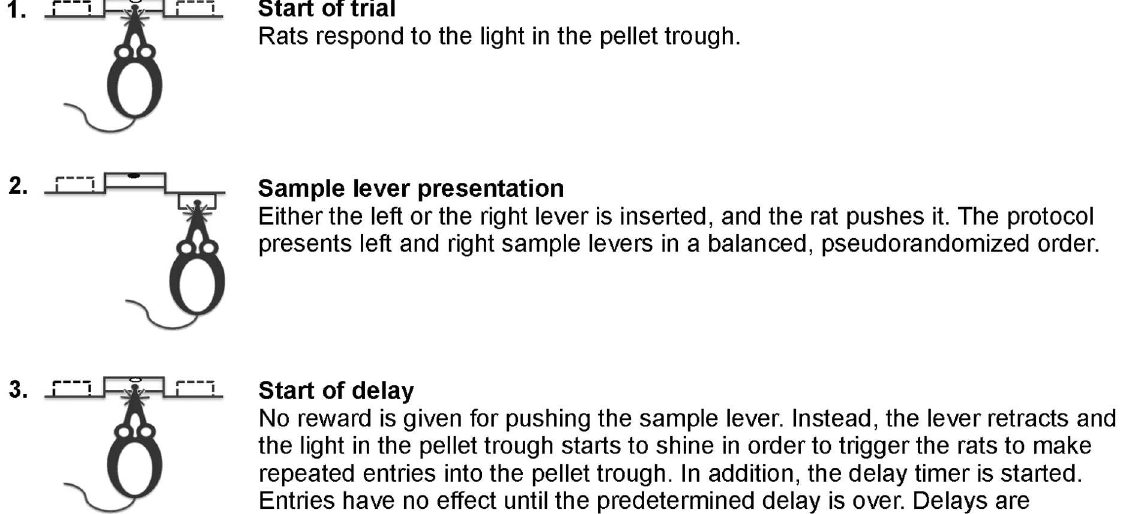
PLOS ONE | DOI:10.1371/journal.pone.0169051 January3,